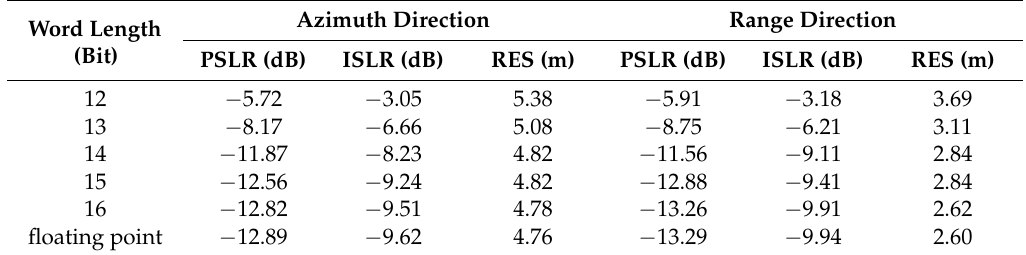
Table 3. Point target imaging quality assessment for different FFT processing accuracies.